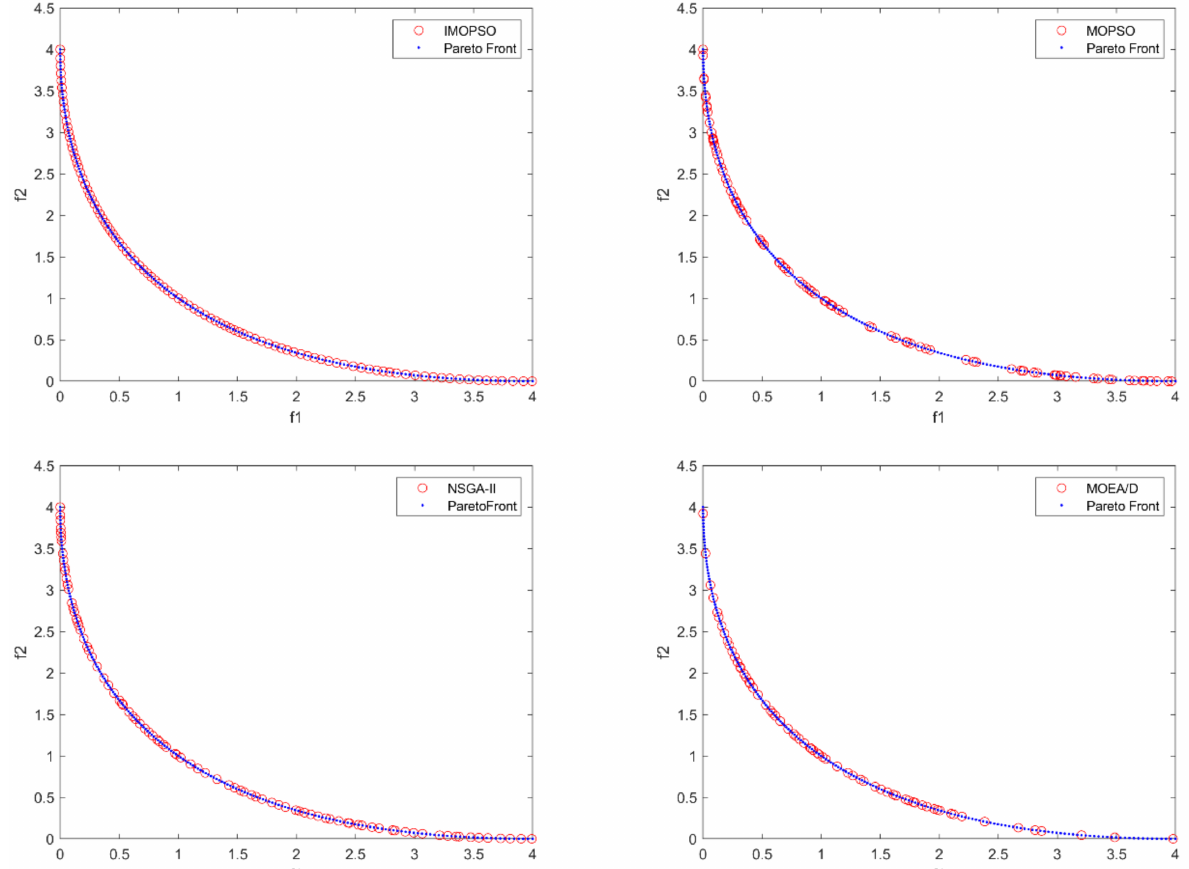
Figure 5. Comparison of the results of four algorithms for solving SCH